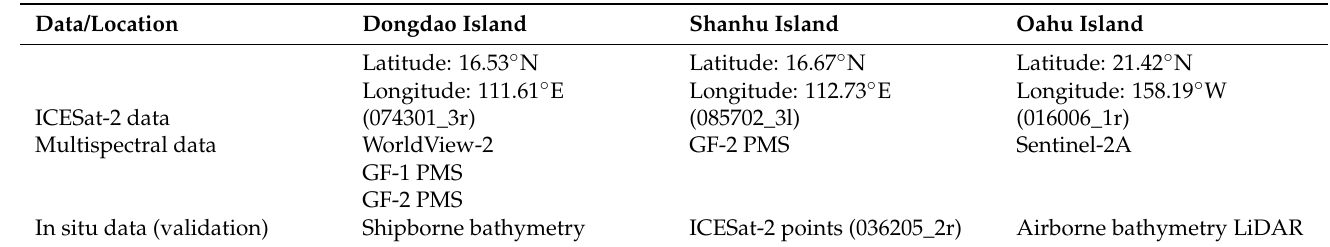
Table 3. Detailed information of the study areas and related